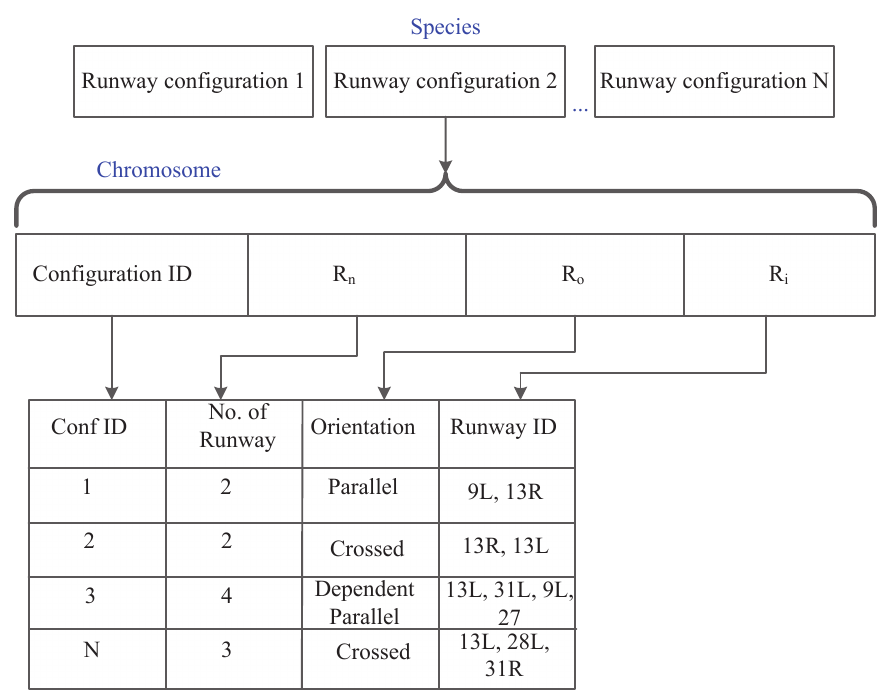
Figure 4. Chromosome (runway